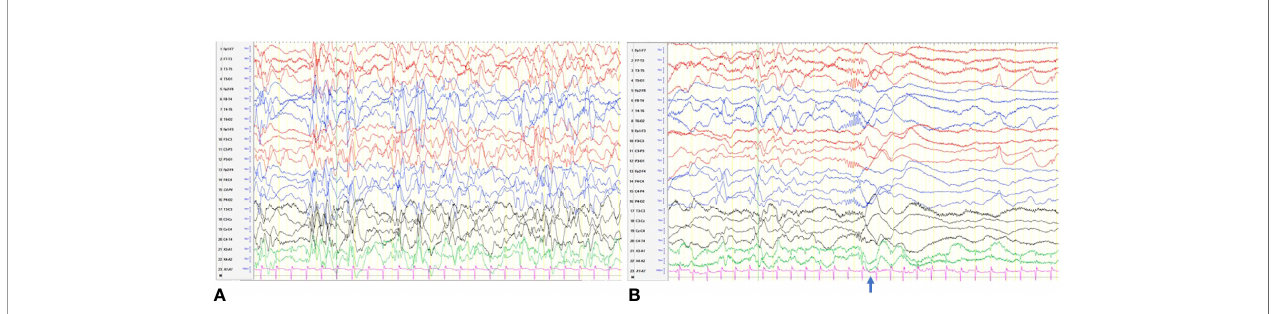
FIGURE 3 | (A) Hypsarrhythmia: discontinuous, asynchronous background with high-voltage irregular slow waves and multifocal spikes. (B) An electrodecremental event. The clinical spasm ( ) was associated with sudden attenuation in